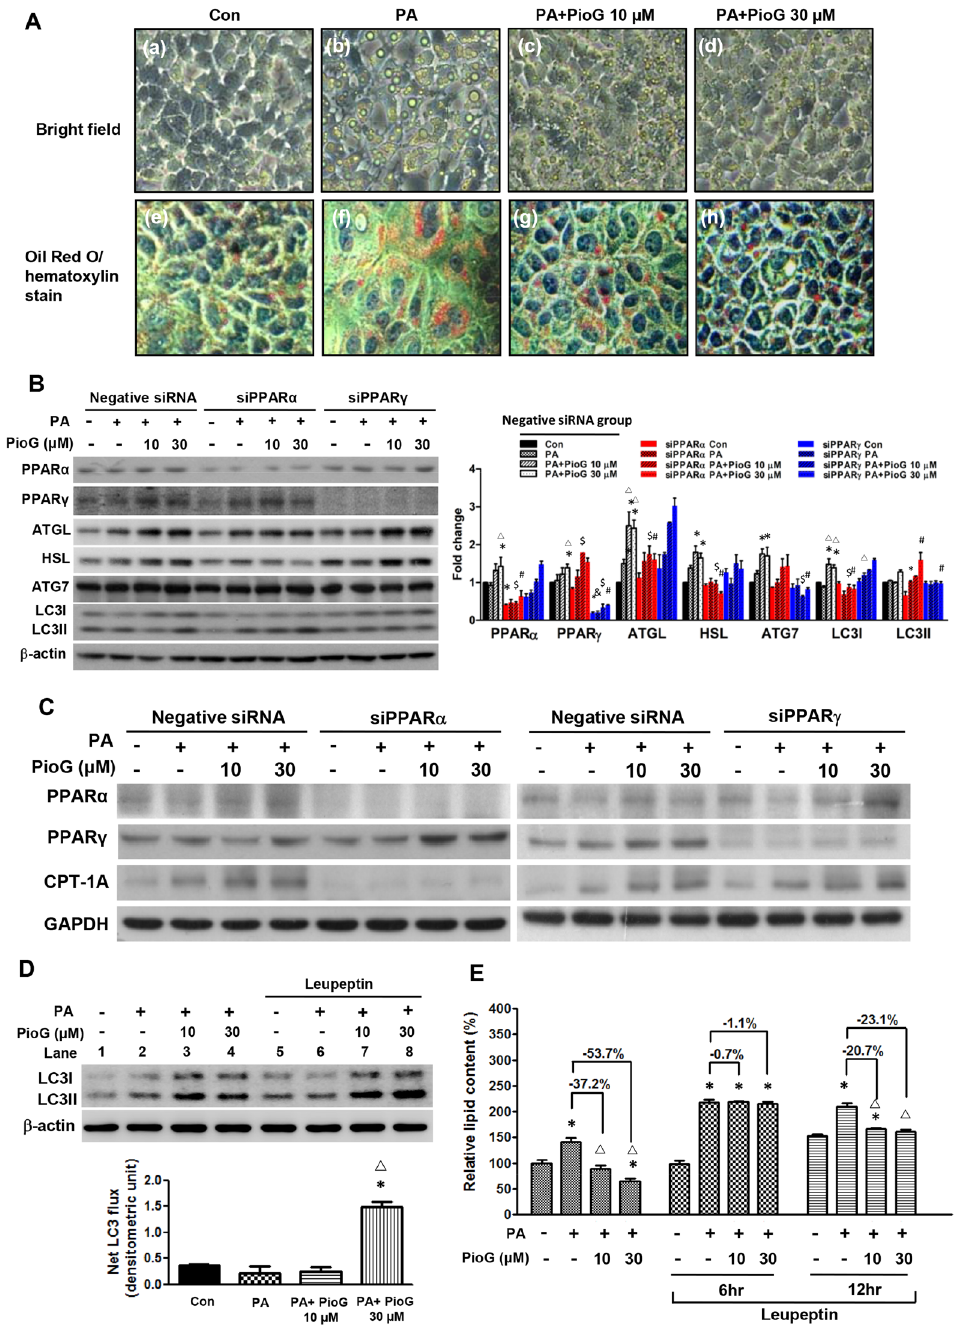
Figure 4. Pioglitazone ameliorated hepatic steatosis through enhancing lipolysis, β -oxidation, and autophagy dependent on PPAR α and PPAR γ activation. (A) AML12 cells treated with (a,e) control (b,f) 400 µ M palmitic acid (PA), (c,g) 400 µ M PA and 10 µ M pioglitazone (PioG), (d,h) 400 µ M PA and 30 µ M pioglitazone. Cells with bright field and Oil-red O/hematoxylin stain to show lipid droplet. Magnification: 400X. (B , C ) AML12 cells, transfected with siRNA against PPAR α , PPAR γ , and non-targeting negative siRNA, were treated with palmitic acid (PA, 400 μ M) with or without pioglitazone (PioG) for 3 days. Protein expressions of the PPAR α , PPAR γ , ATGL, HSL, LC3, and CPT-1A were analyzed to control with GAPDH and β -actin. Data are expressed as fold change of the negative siRNA. P < 0.05 indicated as significant, * vs Control (con), Δ vs PA, $ vs PA + PioG 10 μ M, # vs PA + PioG 30 μ M. (D) Autophagic flux was determined by treating lysosomal inhibitor, leupeptin, for 4 hours to compare the LC3 expression with loading control of β -actin. Net LC3 flux was indicated by the difference of LC3II/ β -actin ratio between leupeptin treated and untreated cells. Con: (lane 5-lane 1), PA: (lane 6-lane 2), PA + PioG10 μ M: (lane 7-lane 3), PA + PioG 30 μ M: (lane 8-lane 4). ( E ) AML12 cells, incubated with PA and pioglitazone as indicated for 48 hours, were then treated with leupeptin (100 µ M) for 6 and 12 hours. The lipid content was determined by Oil-red O stain and quantified by reading absorbance at 492 nm. Data was expressed as fold or percentage change in mean + SEM. P < 0.05 indicated as significant, * vs Con, Δ vs